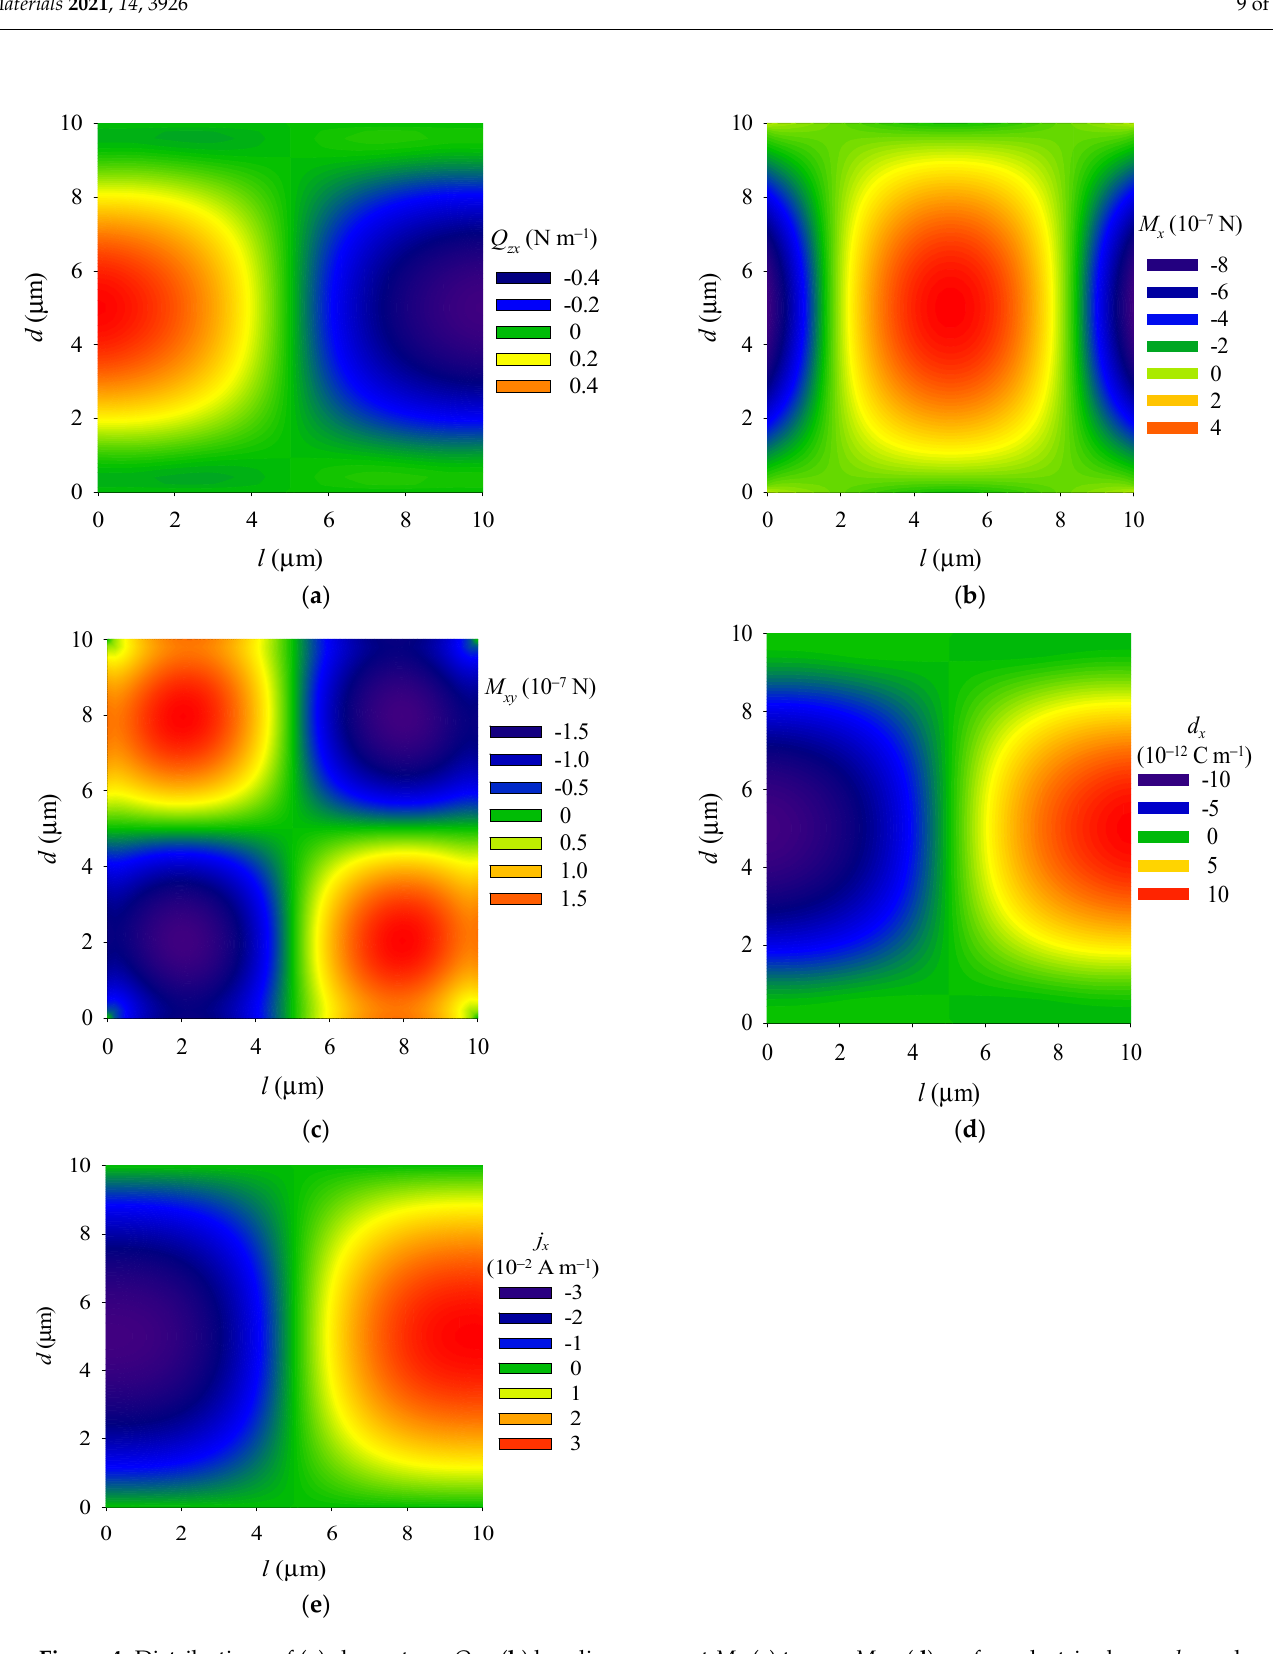
Figure 4. Distributions of ( a ) shear stress Q zx , ( b ) bending moment M x ( c ) torque M xy , ( d ) surface electric charge d x , and ( e ) surface electric current density j x in the plate.